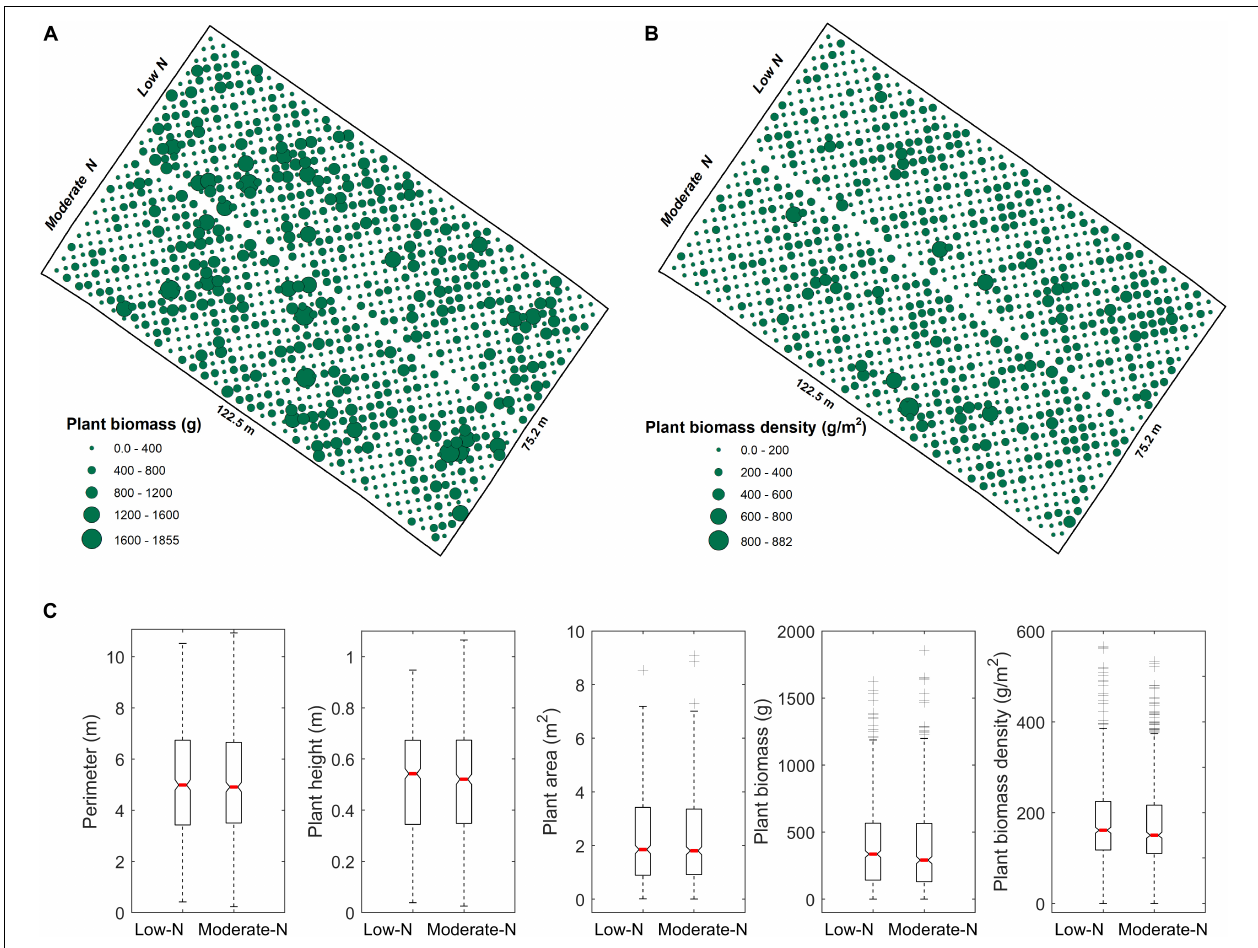
FIGURE 7 | Comparisons of different N treatments for switchgrass. (A) Spatial distribution of switchgrass biomass over the experimental field mapped to individual plants. (B) Spatial distribution of switchgrass biomass density that is normalized by plant canopy coverage area. (C) Boxplots for plant phenotyping parameters (i.e., plant perimeter, height, and plant area), as well as plant yield (single plant biomass and biomass-density) between two levels of N treatments, where the red line on the box indicates the median, and the bottom and top edges of the box indicate the 25 th and 75 th percentiles,